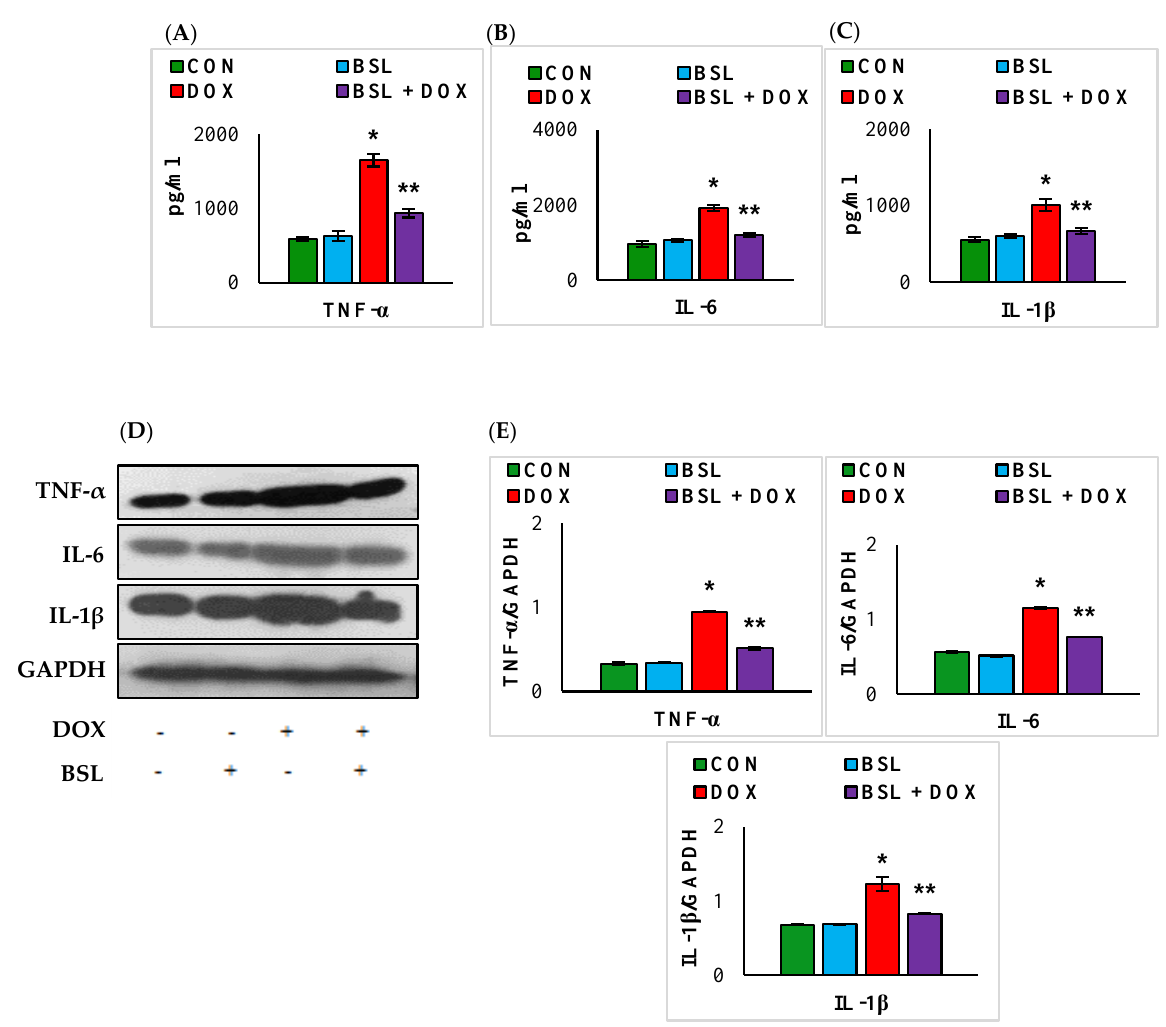
Figure 4. Histopathology of the testis. Testes of normal control rats and rats treated with α -bisabolol alone showed no pathological alterations. Rats treated with DOX alone showed severe derange- ment of testicular morphology, whereas α -bisabolol pre- and co-treatment reinstated the near